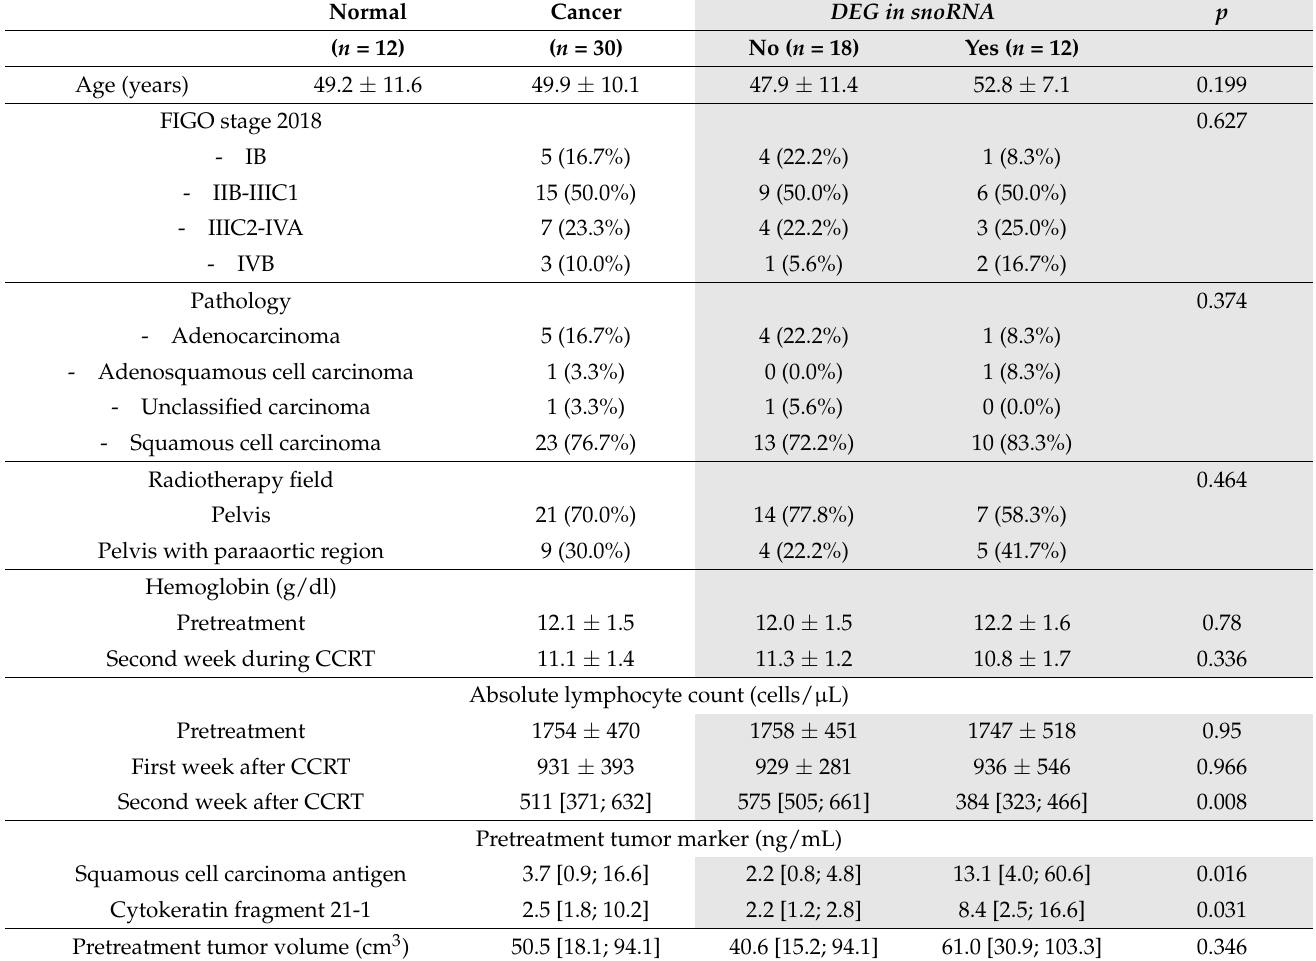
FIGO—International Federation of Gynecology and Obstetrics; CCRT—concurrent chemoradiotherapy; DEG—differentially expressed genes; snoRNA—small nucleolar RNA. Continuous variables described using median [interquartile range] or mean ± standard